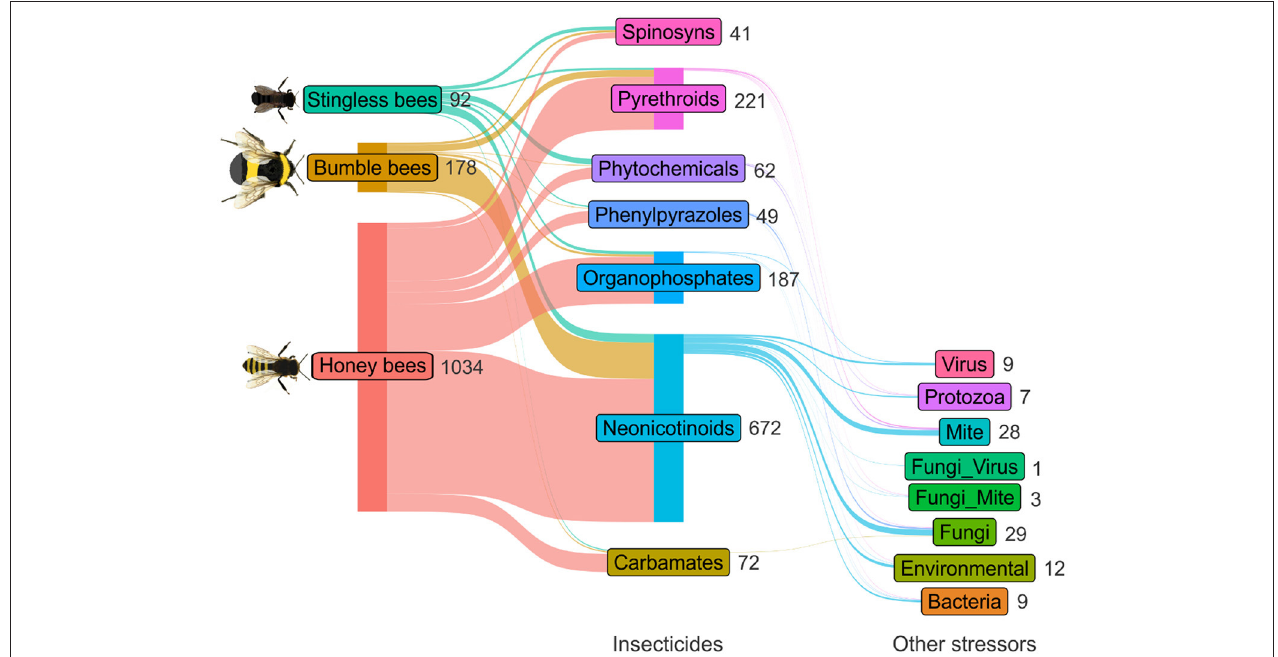
FIGURE 3 | Interaction flows among insecticides and other stressors that were tested in the main groups of bees found in the literature review ( n = 1,304) of toxicological assessment of the impact of agrochemicals on insect pollinators. The values on the right side of each node indicate the number of trials. The thickness of the nodes (rectangles) and arcs (links going from one node to another) is proportional to the frequency of interactions. Terms separated by dash indicate that both terms were assessed.